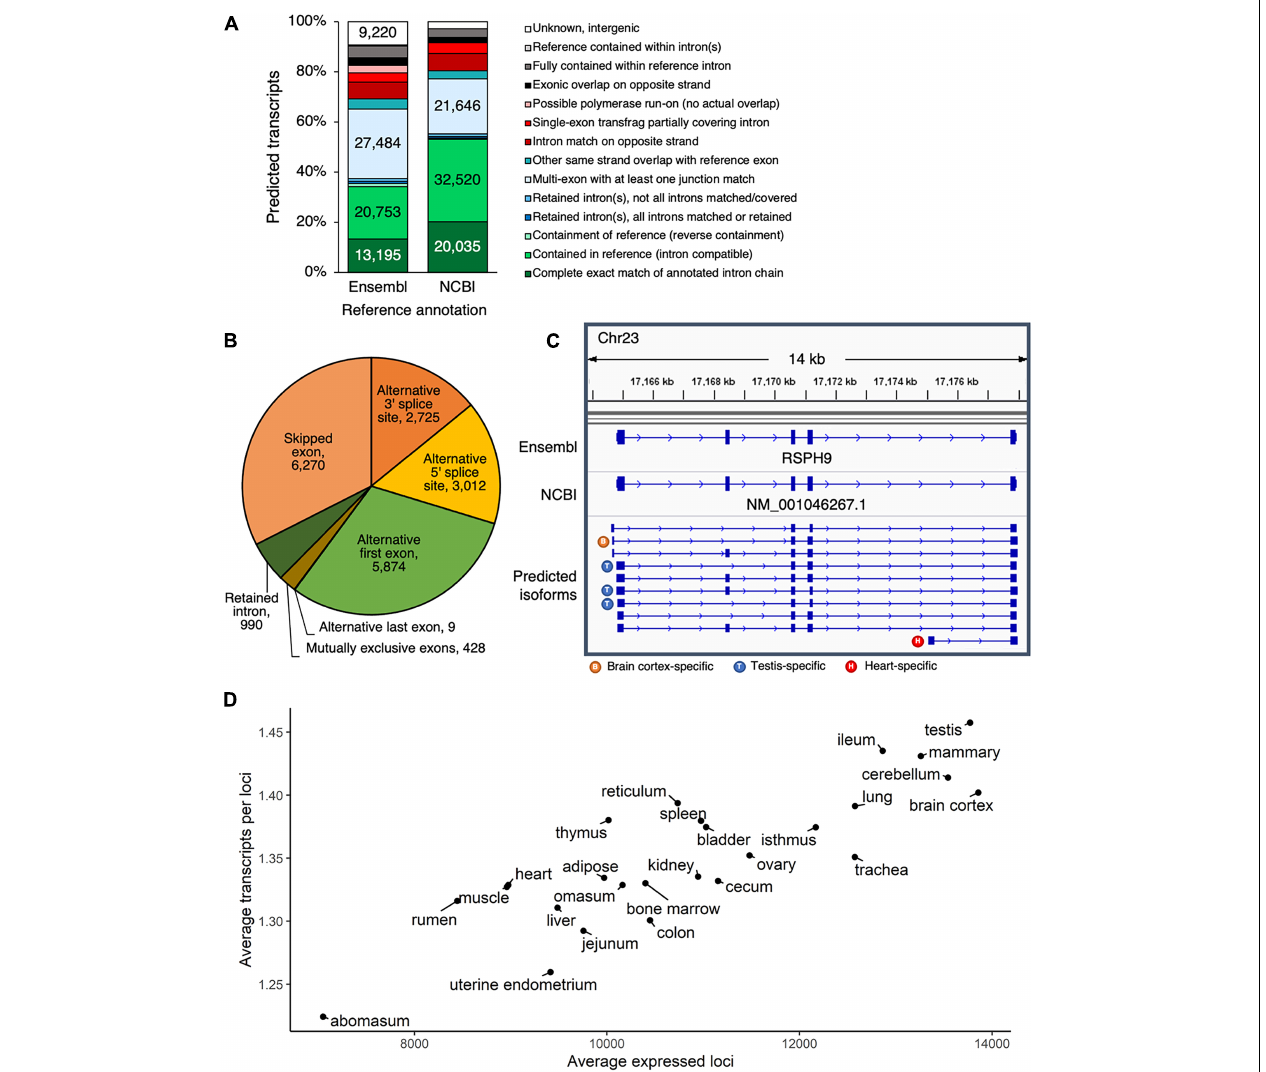
FIGURE 2 | Predicted transcripts capture transcriptome complexity. (A) Comparison of predicted isoforms to Ensembl and NCBI gene annotations. (B) Frequency of alternative splicing events in predicted multi-exon transcript isoforms. (C) Predicted isoforms at the RSPH9 locus, which is thought to code for a component of motile cilia and flagella. In humans, multiple splicing is known to produce transcript variants, but only one transcript had been annotated in cattle, according to both the Ensembl and NCBI annotations. (D) Based on the predicted transcript set, number of expressed loci and ratio of expressed transcripts per loci, averaged per